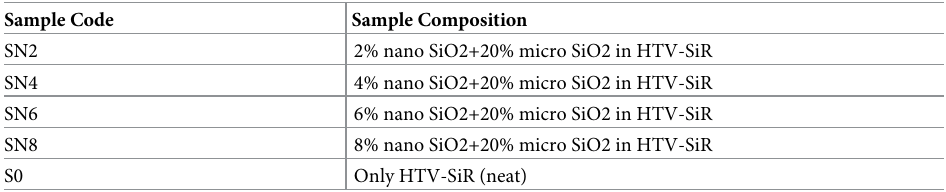
Table 1. Sample code and their